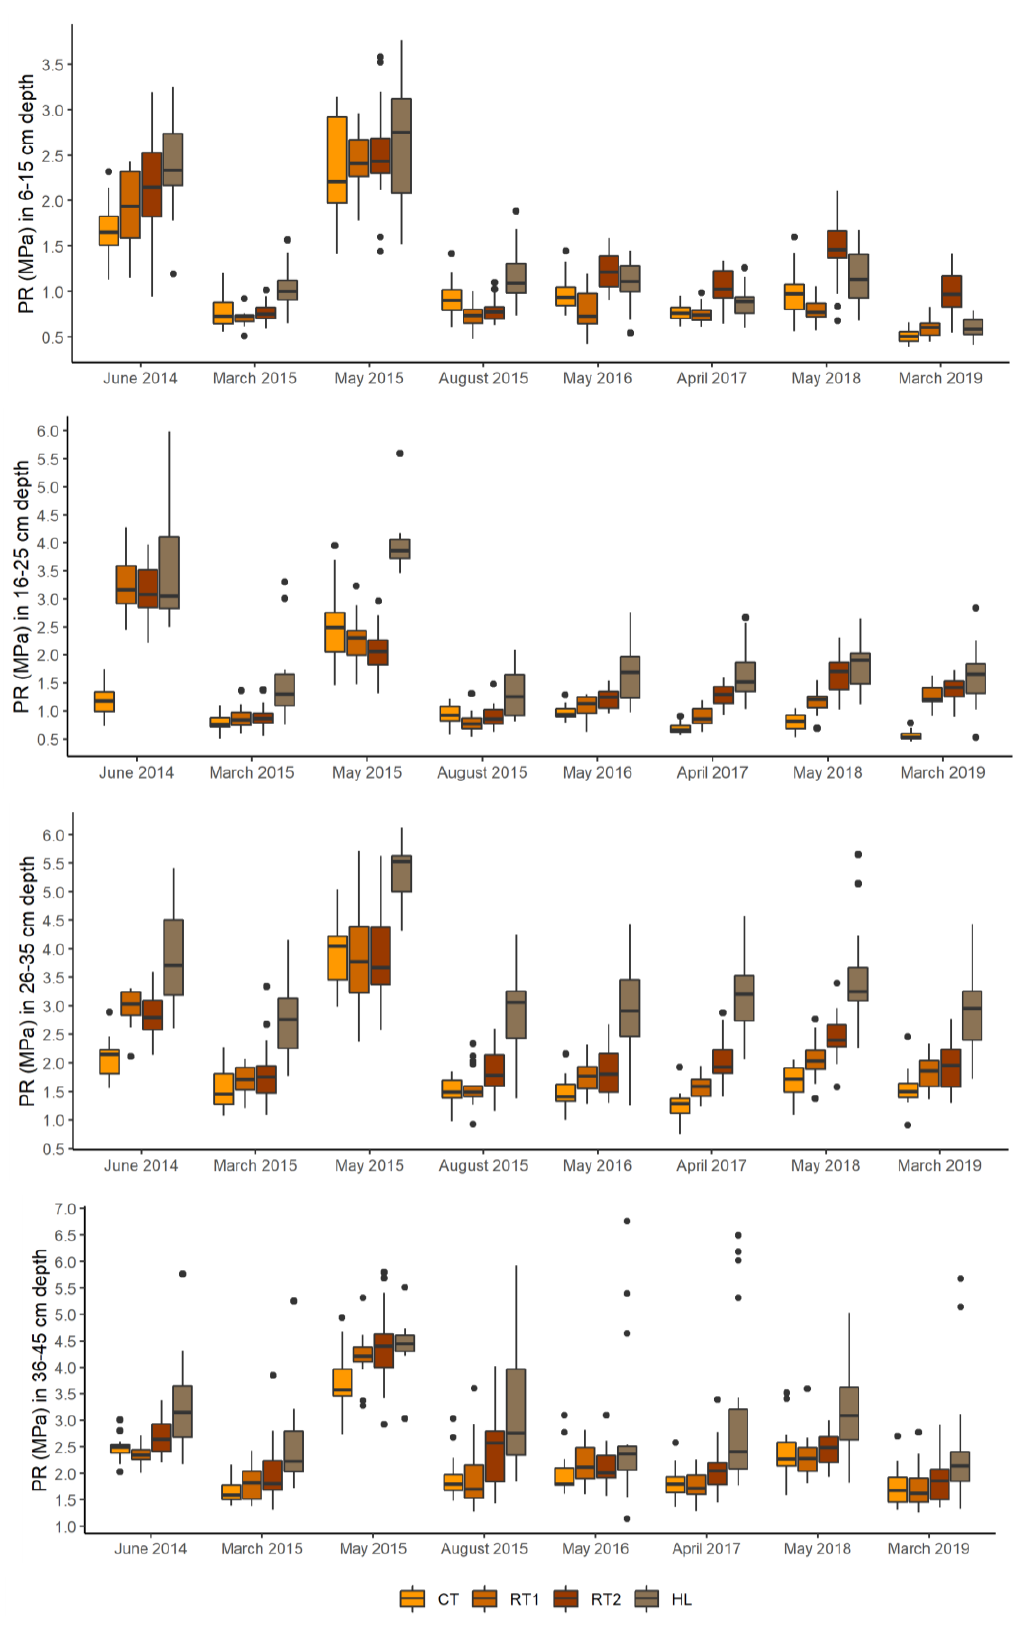
Figure 4. Box-whisker plots of penetration resistance (PR) comparing continuously conventional tilled plot (CT), both reduced tilled plots affected by one-time inversion tillage (RT1: chisel plough; RT2: disc harrow) and the headlands (HL) at 6–15 cm, 16–25 cm , 26–35 cm, and 36–45 cm.